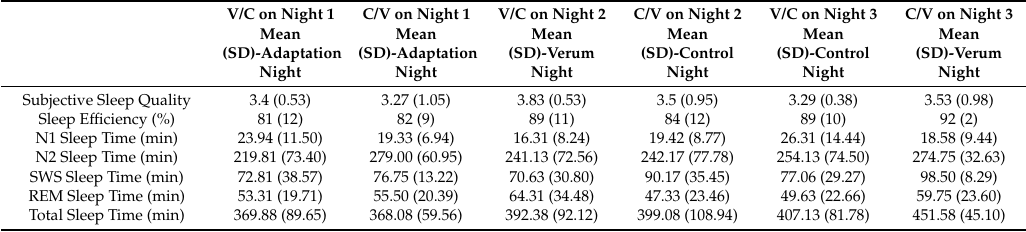
Table 1. Mean Values on Sleep Quality, Sleep Efficiency, N1, N2, Slow-Wave and, REM Sleep Time for Each Group Per Each Night of In-Laboratory